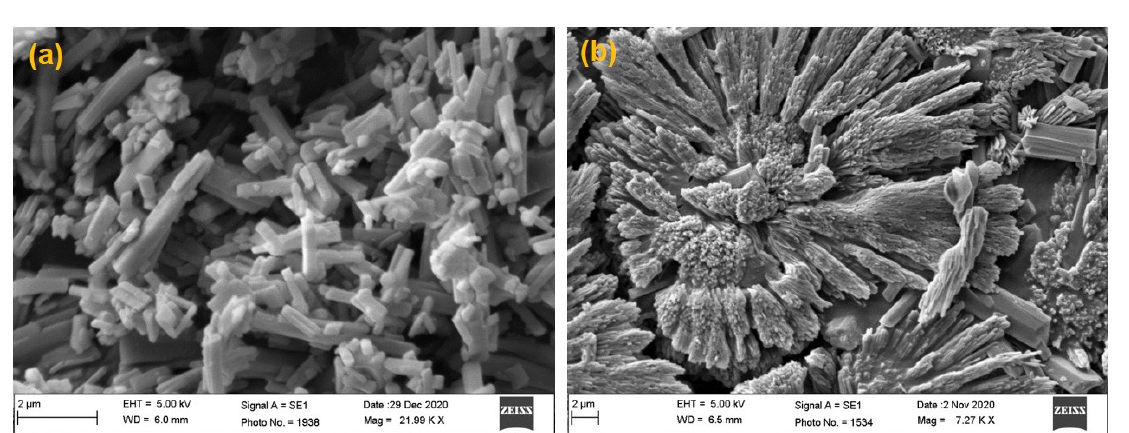
Figure 2. SEM images of elongated and rod-shaped NCs ( a ); unusual, larger, and rosette-shaped NCs ( b ). Both these NCs were stabilized by PVA (1%, w / v ) alone.